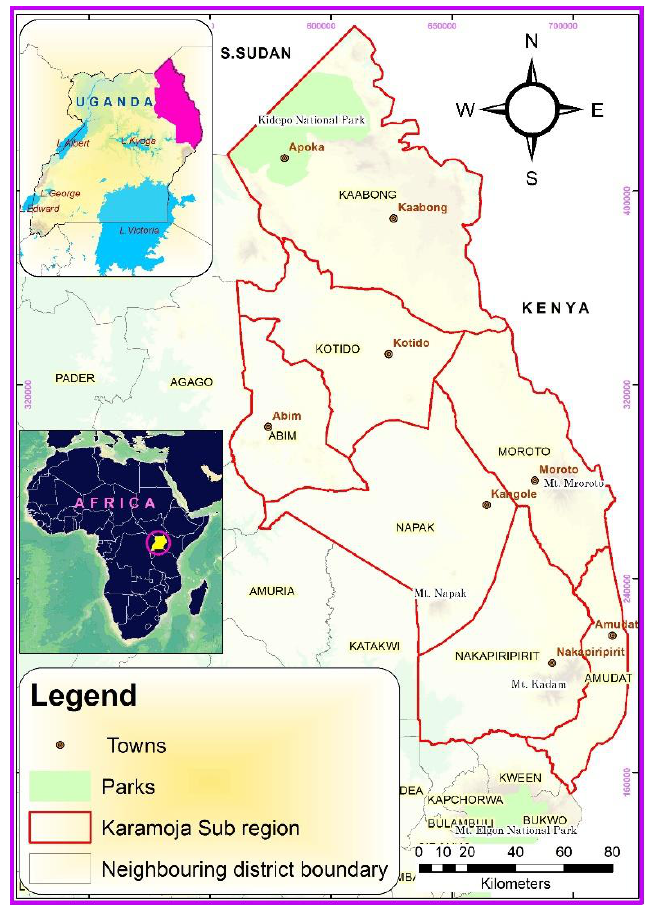
Figure 1. Location of Karamoja sub-region (Source: Authors).